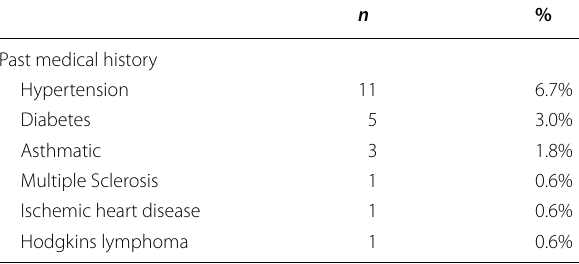
Table 1 Past medical history of study